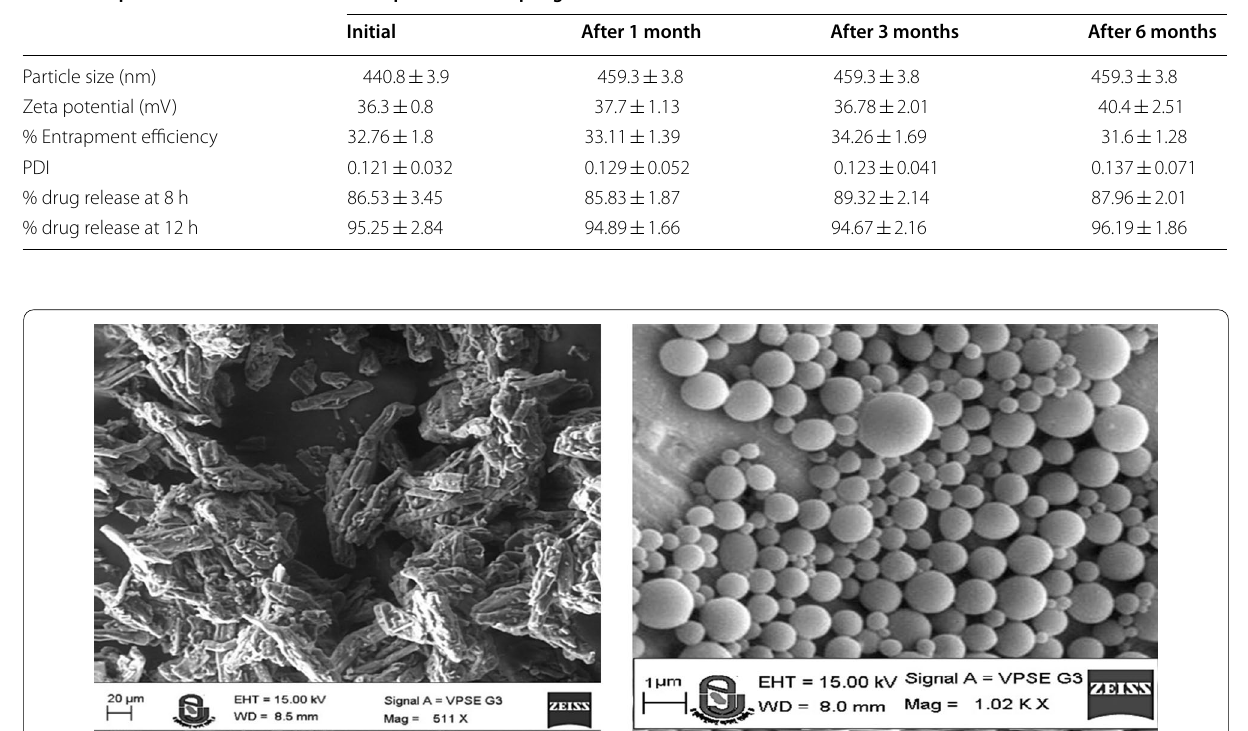
Table 3 Stability study of optimized batch pirfenidone nanoparticles Evaluation parameter